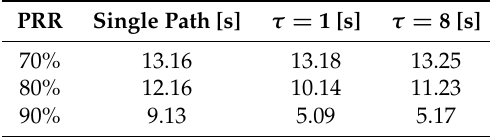
Table 3. Max latencies for different link qualities.